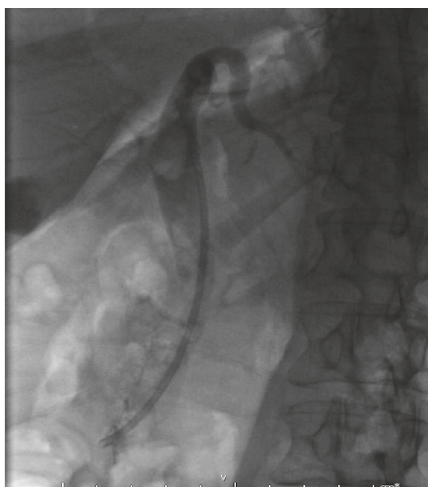
Figure 1: Gallstone seen near top of common bile duct.